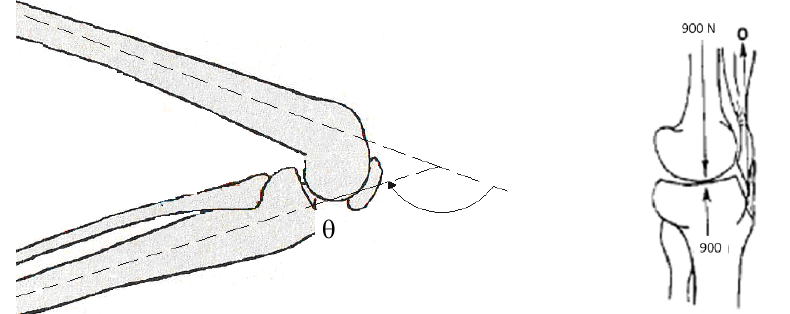
Figura 3: Convenzione per l’angolo di flesso-estensione  compreso tra il prolungamento del segmento coscia rispetto al segmento gamba, e configurazione per  pari a zero. Figure 3: Angle of flexion-extension  between the extension of the femoral axis with respect to the tibial axis, and configuration for   Nel caso in cui l’angolo di flesso-estensione varia, condizione che si realizza anche durante la normale deambulazione, il